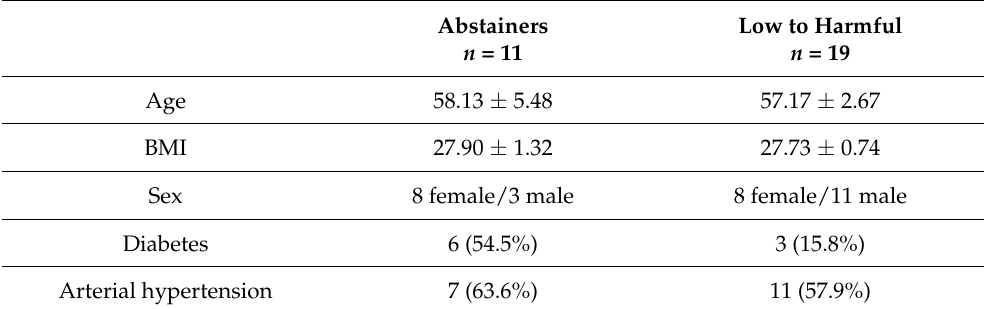
Table 1. Grouping based on the current drinking habits following statements of the AUDIT ques- tionnaire comparing abstainers (none up to 1 × alcohol per month) versus low to harmful drinking (minimum 2–4 × alcohol per month and